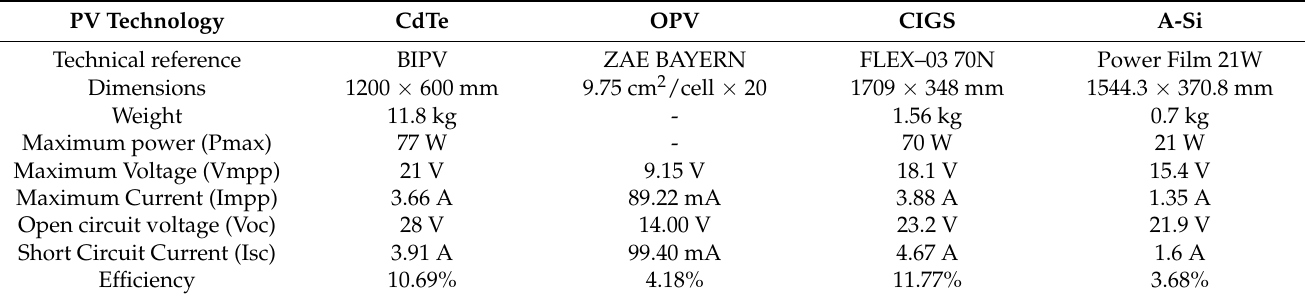
Table 1. Technical characteristics of PV panels and OPV mini